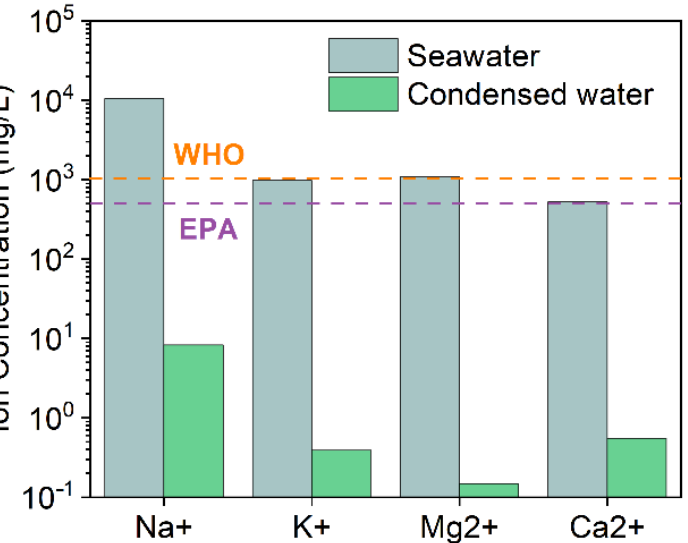
Figure 5. Ion concentrations of the seawater and the water condensed from solar steam generation by the WHP-C.